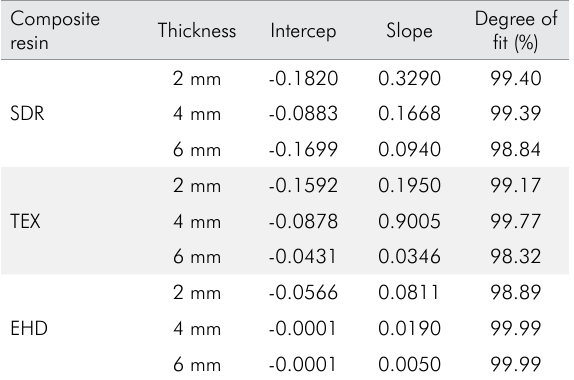
Table 3. Results of linear regression of Radiosity (EB) vs radiant exposure time.